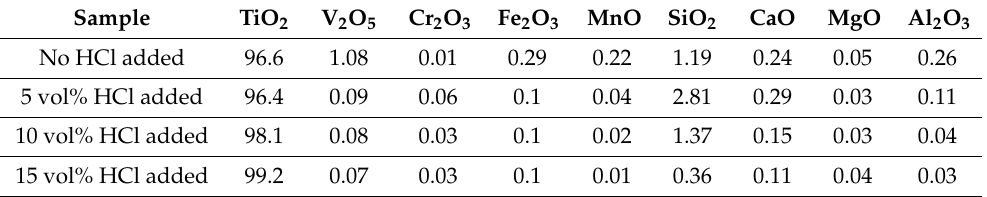
Figure 6. XRD patterns of the hydrothermal product obtained at 140 ◦ C. Table 5. Compositions of hydrothermal precipitation product at 140 ◦ C (wt. %).